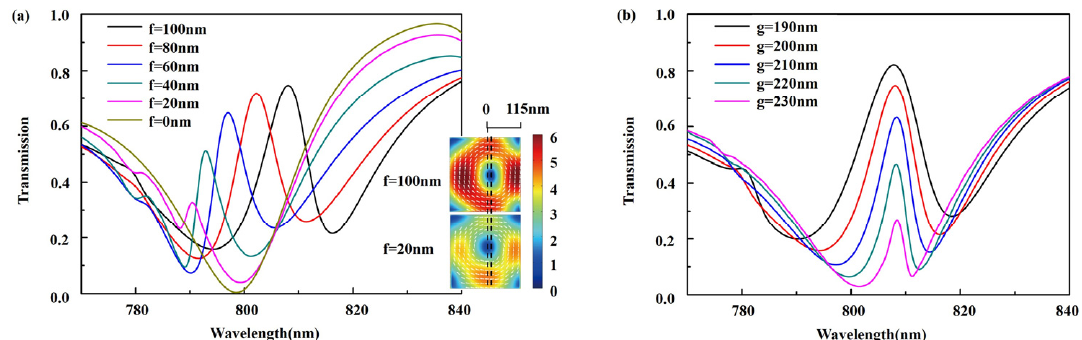
Figure 5. Simulated transmission spectrum of the periodic cuboid-bar nanostructure EIT metasurface with ( a ) different vertical spacing, ( b ) different horizontal spacing g between the cuboid and the bar. Inset shows the distribution of electric field with displacement currents in y-z plane inside the bar when f = 20 nm and f = 100 nm at the EIT peak.